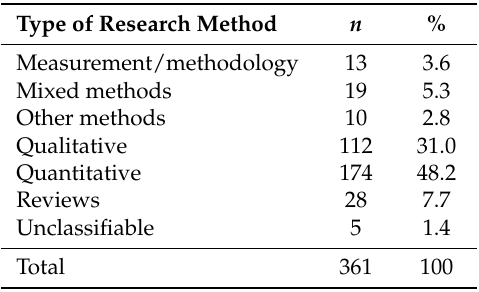
Table 5. Distribution of scientific production by type of research methods ( n and